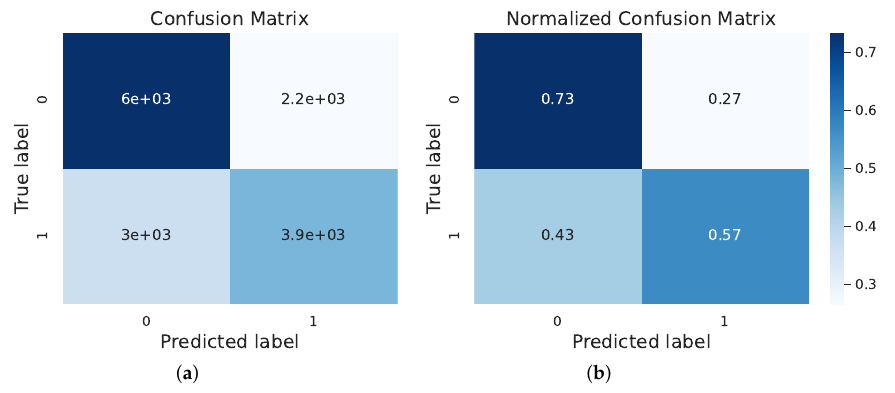
Figure 4. The confusion matrix of stacking. ( a ) confusion matrix; ( b ) normalized confusion matrix. The plots reveal the performance of identifying the various states of frailty; among them, “frail” had a better